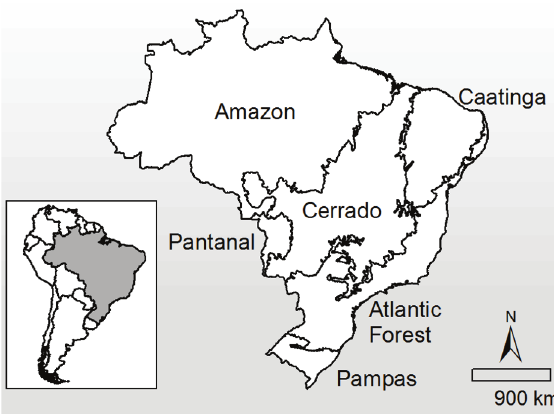
Figure 2 - Study area, comprising Brazil and its